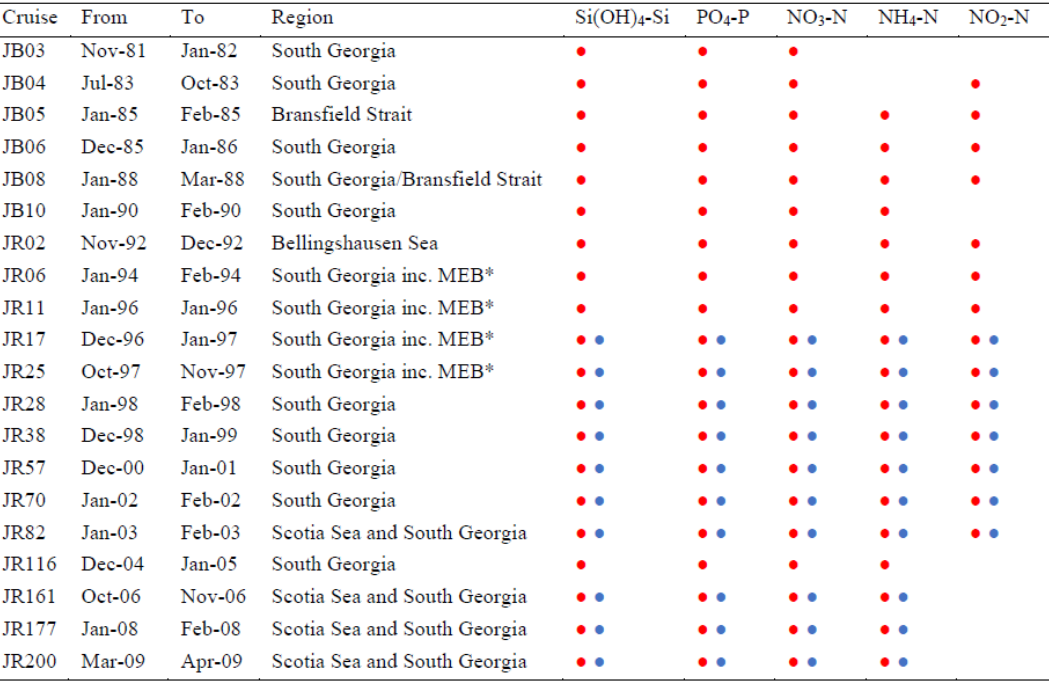
Table 1. Cruise, duration, region and nutrients measured at CTD stations ( ) and during transects ( ). * MEB: Maurice Ewing Bank transect between 48 ◦ S, 44 ◦ W and 54 ◦ S, 39 ◦ W. Concurrent temperature and salinity values are presented for all CTD profiles and for cruises JR161, JR177 and JR200 transect